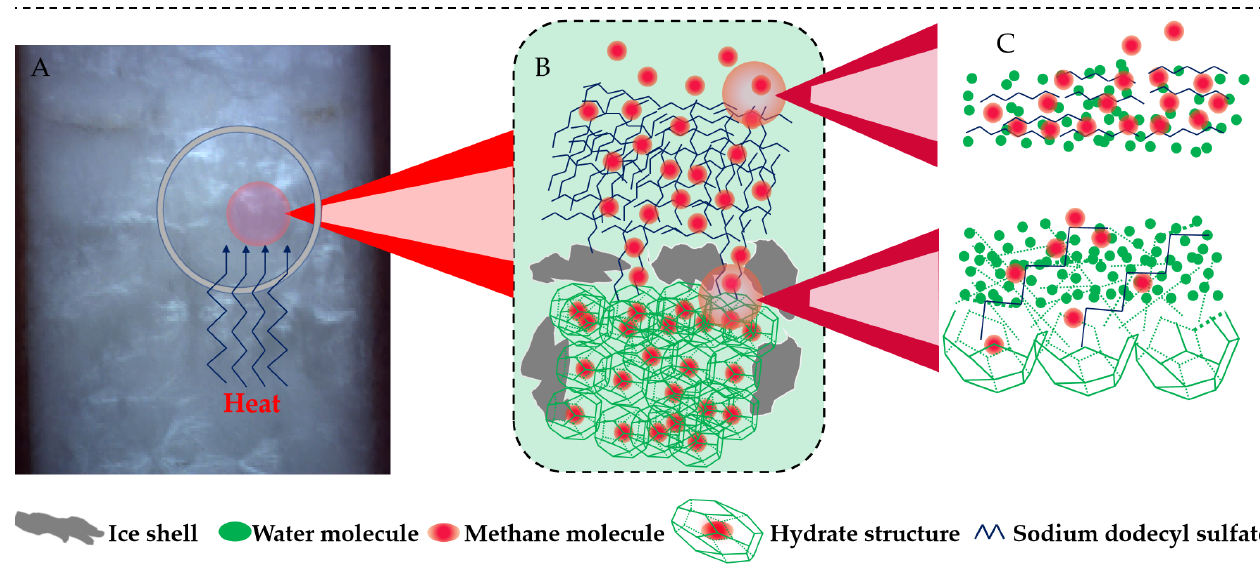
Figure 11. Schematic of the action mechanism of the surfactant SDS on the self-preservation effect of the CO 2 hydrate.